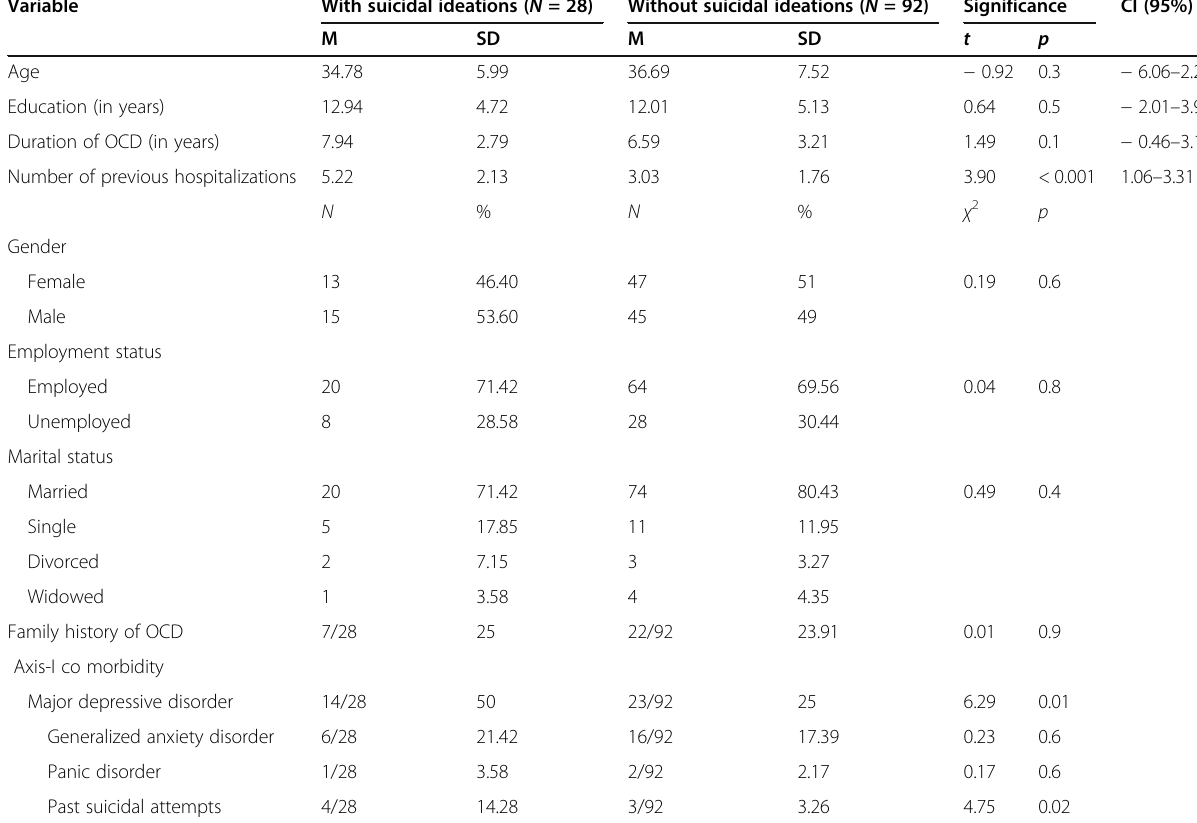
Table 1 Demographic and clinical characteristics of OCD patients with and without current suicidal ideations ( n = 120)